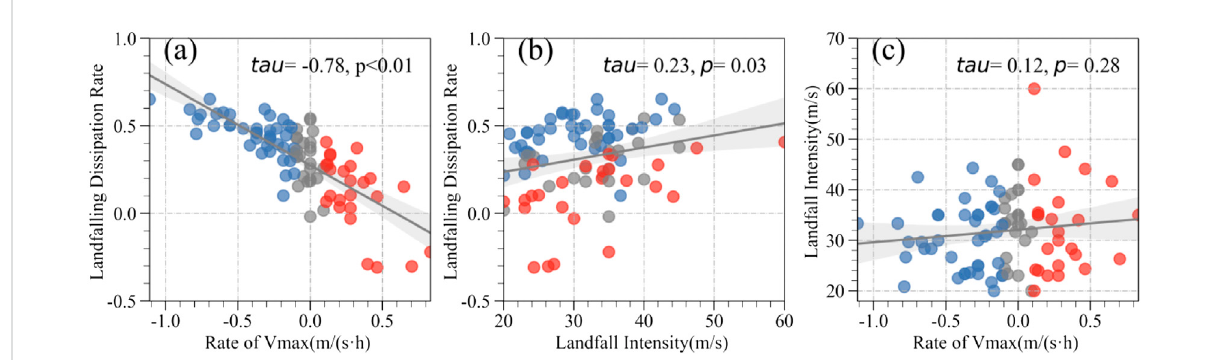
FIGURE 3 (A) The relationship between the rate of V max ( r vmax ) and landfalling dissipation rate (LFDR) in intensifying (red), neutral (gray) and weakening (blue) TCs. Solid line represents the linear regression trend. Dashed lines show the 99% con fi dence interval. (B) As in (A) but for landfall